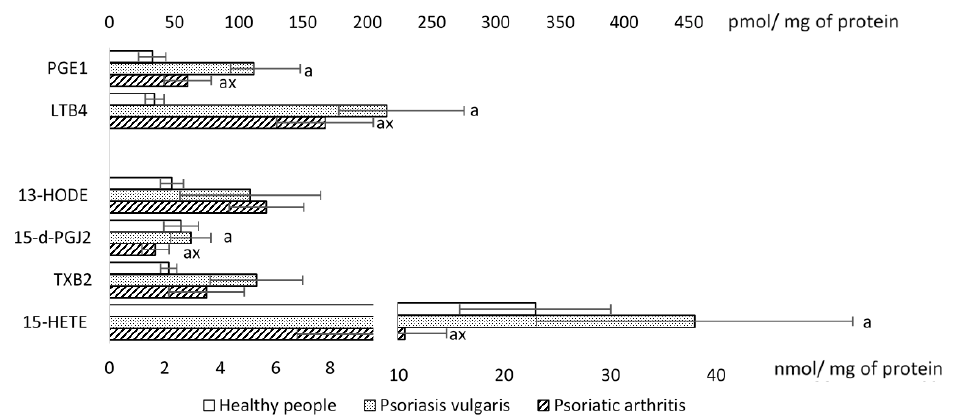
Figure 5. The level of the eicosanoids in mononuclear cells of patients with psoriasis (n = 32), psoriatic arthritis (n = 16), as well as healthy subjects (n = 16). Data points represent the mean ± SD; a, significantly di ff erent from healthy subject, p < 0.05; x, significantly di ff erent from patients with psoriasis vulgaris. Prostaglandin E1 (PGE1), leukotriene B4 (LTB4), 13-hydroxyoctadecadienoic acid (13HODE),